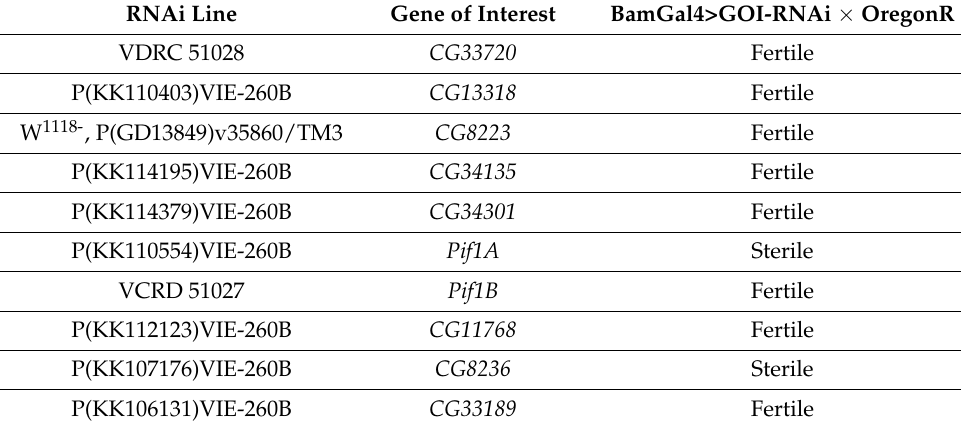
Table 2. Male fertility status of selected Drosophila RNAi lines.